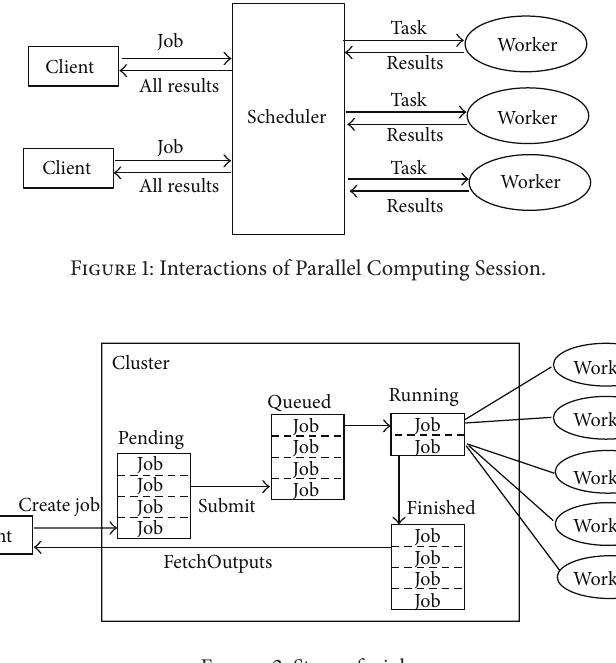
Figure 2: Stage of a